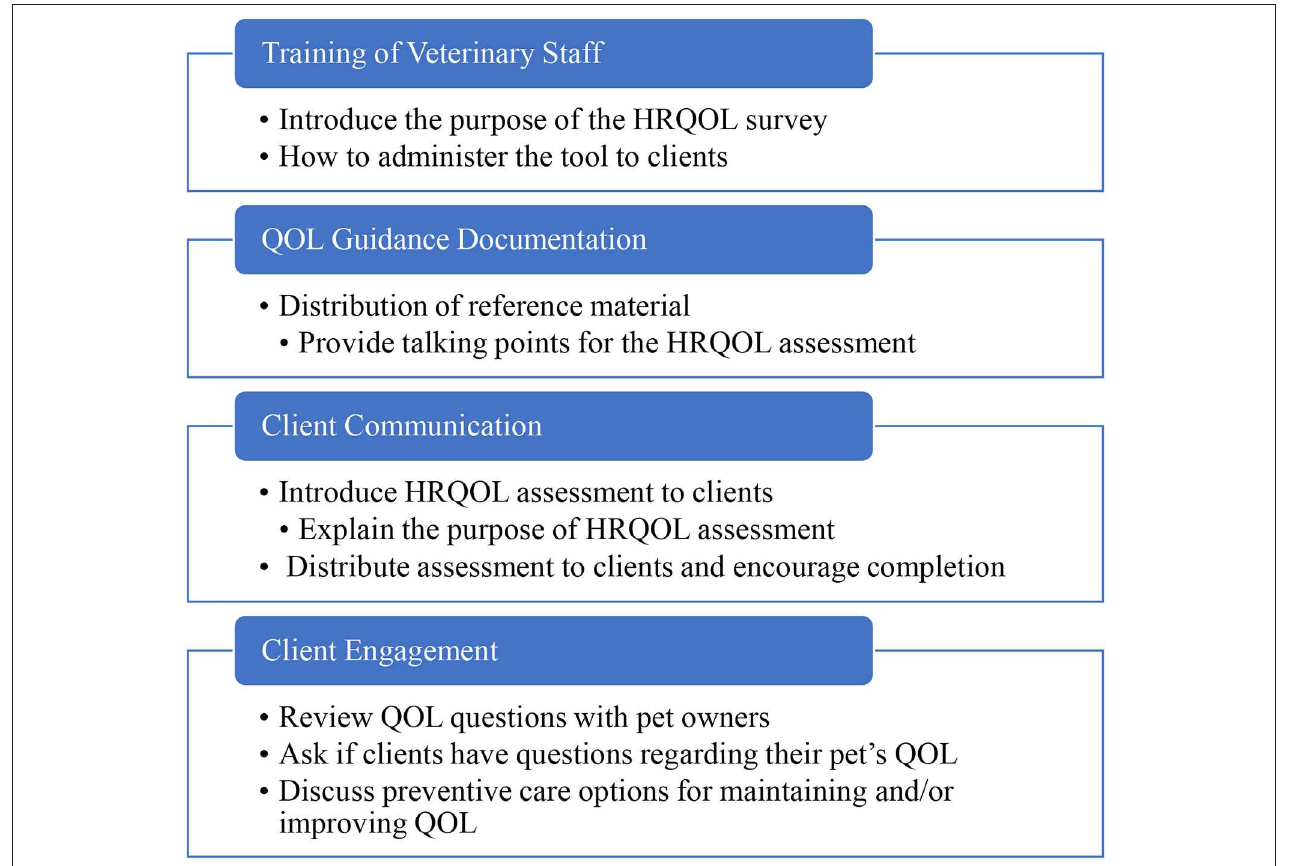
FIGURE 4 | Conceptual framework for implementing a QOL assessment in clinical